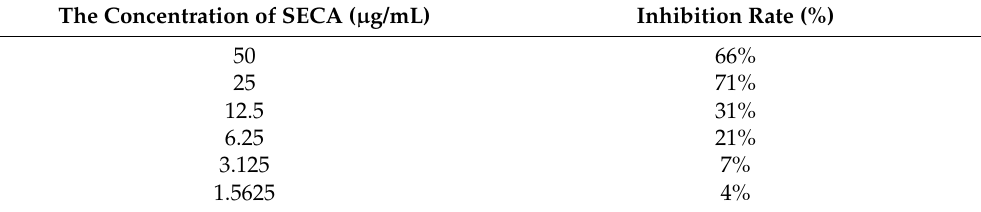
Table 1. The cytotoxicity of SECA on MDCK cells.